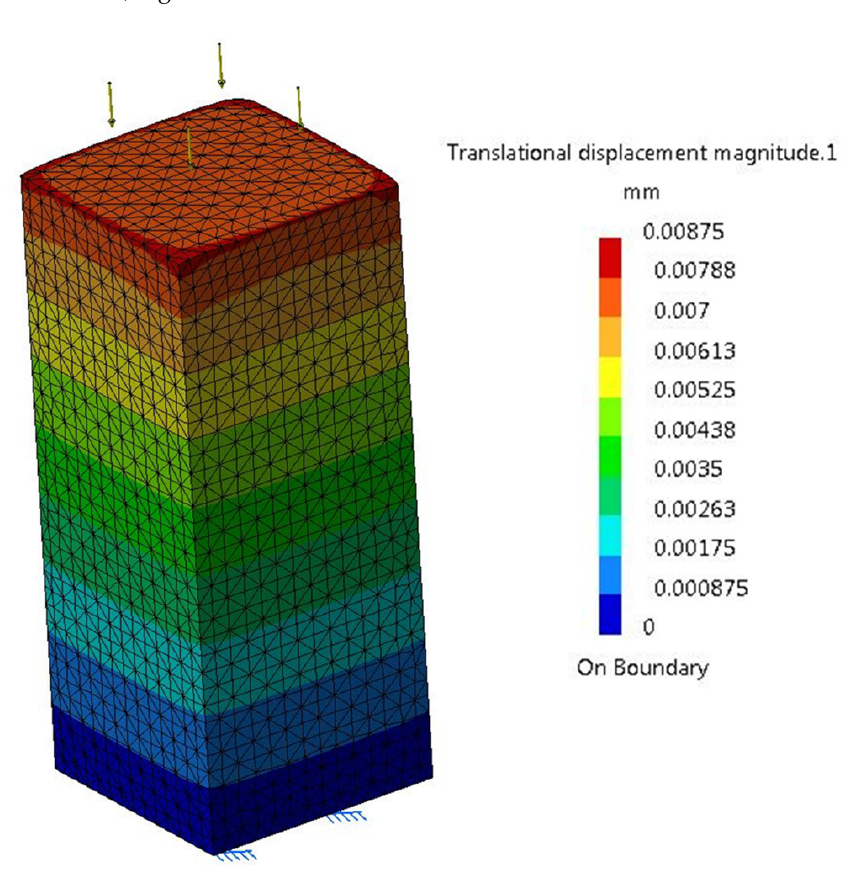
Figure 3. Compression pole loaded with F = 250 kN evenly distributed.